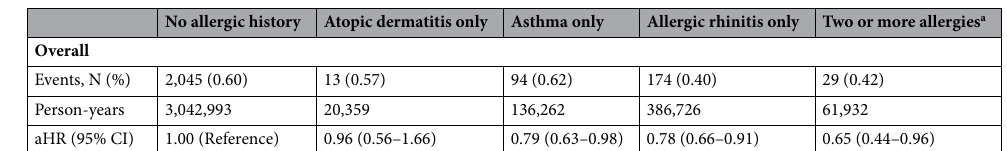
Table 4. Association of allergic disease incidence with risk of liver cancer incidence. Hazard ratio calculated by Cox proportional hazards regression analysis after adjustments for age, sex, body mass index, Charlson comorbidity index, household income, smoking, alcohol consumption, physical activity, systolic blood pressure, fasting serum glucose, total cholesterol, history of hepatitis B virus/hepatitis C virus infection and liver cirrhosis and the number of outpatient visits. a Having the history of allergic diseases of either any two kinds of allergies among allergic rhinitis, atopic dermatitis, asthma or all of three allergies.